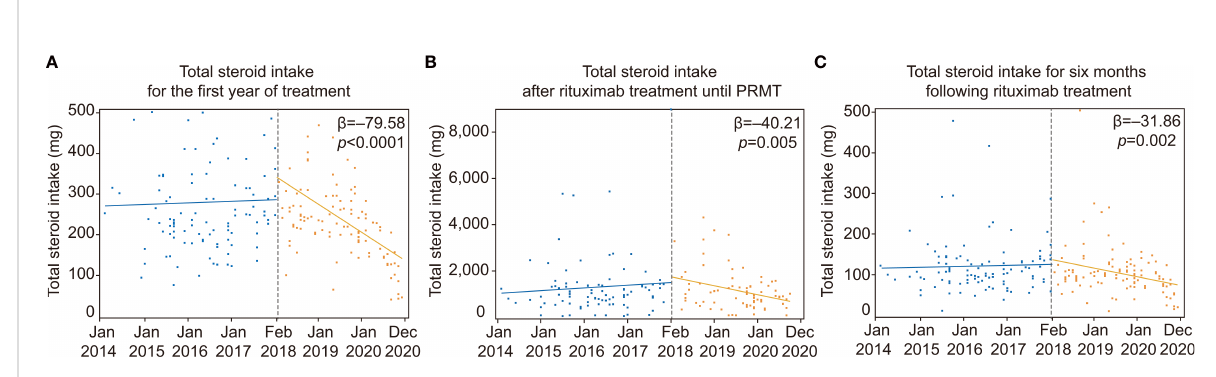
FIGURE 2 ITS analysis of changes in total steroid intake. ITS analysis of the implementation of rituximab reimbursement. (A) Total steroid intake for the fi rst year of treatment before and after the rituximab reimbursement policy. (B) Changes in total steroid intake after rituximab treatment until achieving PRMT before and after the rituximab reimbursement policy. (C) Total steroid intake over the six months following rituximab treatment before and after the rituximab reimbursement policy. PRMT, Partial remission under minimal therapy; ITS, Interrupted time